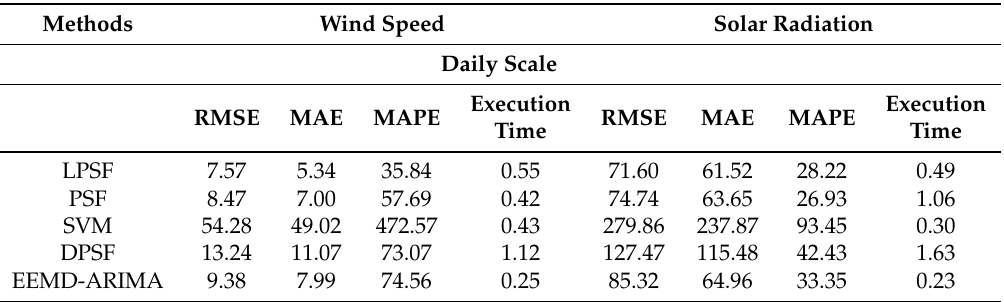
Table 1. The statistical performance of the forecasting wind speed and solar radiation at Robinson station for the daily, weekly and monthly time scale for the applied (LSPF and PSF) and the comparable predictive models (i.e., SVM, DPSF and